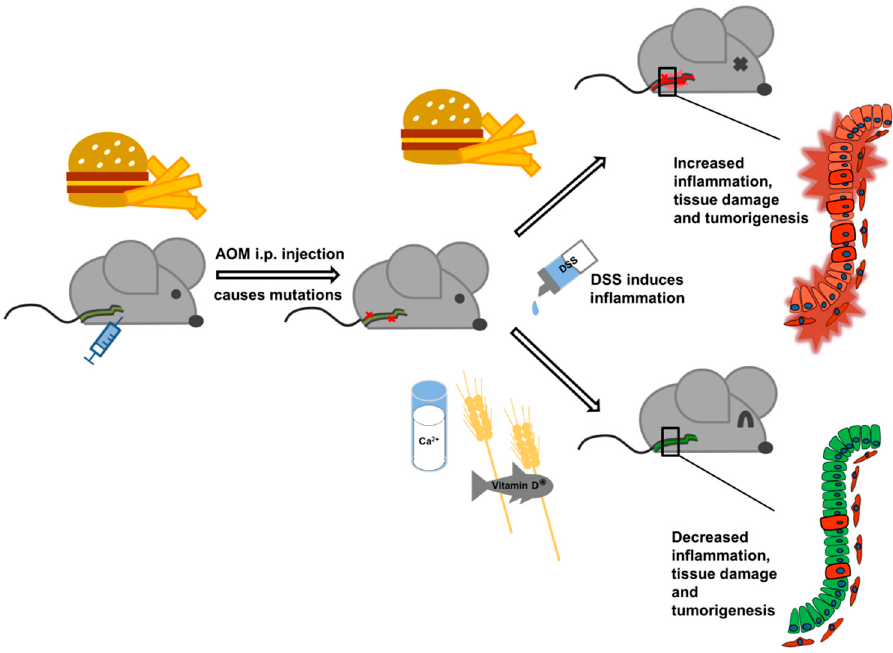
Figure 8. E ff ect of a Western Diet in the chemically-induced colorectal cancer model. Figure S1: Body weight change at the end of the last DSS cycle relative to the day of AOM injection., Figure S2: E ff ect of feeding the test diets for 117 days in the naïve groups not exposed to AOM / DSS on body weight change ( A ), colon length ( B ), no. of lymph follicles in whole colon ( C ), spleen weight ( D ) and liver weight ( E )., Figure S3: E ff ect of the diet on ( A ) severity of chronic inflammation and ( B ) mucosal architecture in the colon., Figure S4: E ff ect of diet on expression of VDR protein in ( A ) healthy or ( B ) in aberrant crypts., Table S1: Composition of the experimental diets. Table S2: List of PCR primers used in this study, Table S3: E ff ect of the diet on mRNA expression of genes of the Wnt pathway, proliferation and survival, intestinal barrier proteins, inflammation and the vitamin D system as well as the casr in colon ascendens (CA) and colon descendens (CD) of AOM / DSS-treated mice .